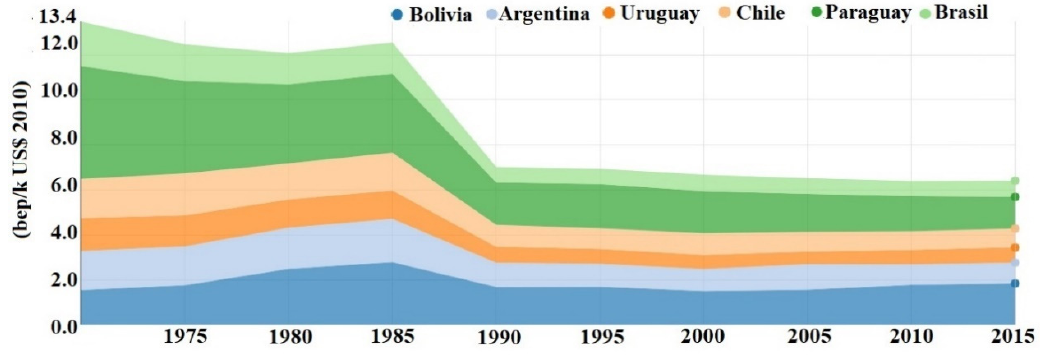
Figure 3. Evolution of energy intensity of South American countries [56].